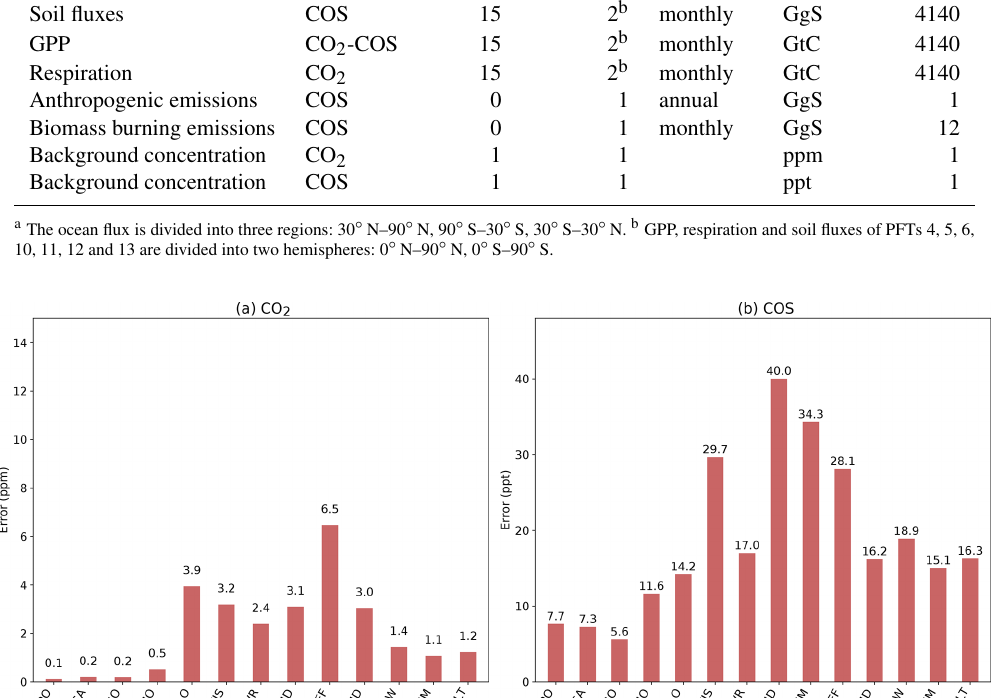
Table 2. Controlled variables for 1 year. The size of the control vector is equal to 149630 for the inversion period 2008–2019. Parameters Species Number Number of Frequency Units Number of of PFTs regions parameters Oceanic fluxes COS